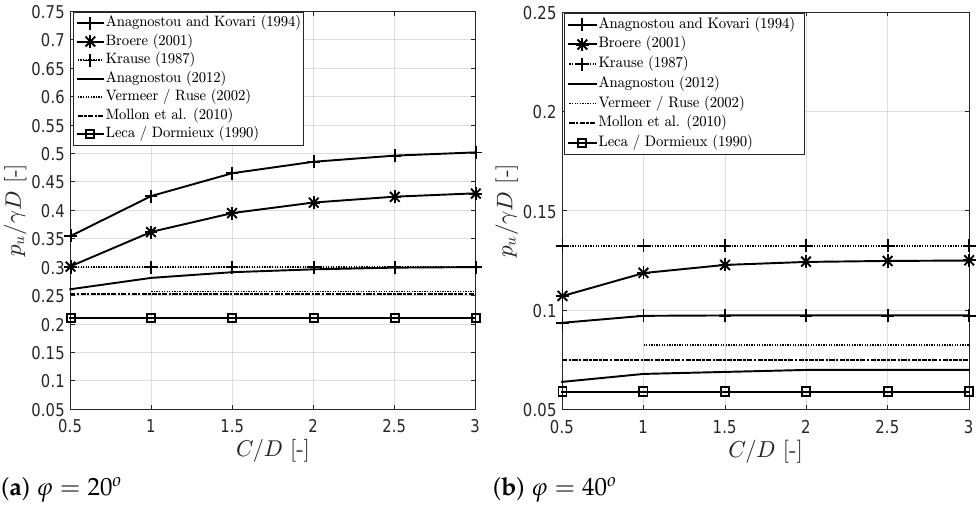
Figure 8. Normalized support pressure ( p u / γ D ) as a function of cover to diameter ratio